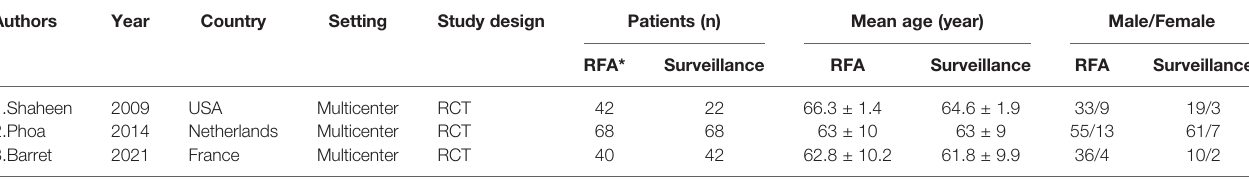
TABLE 1 | The main characteristics of the included